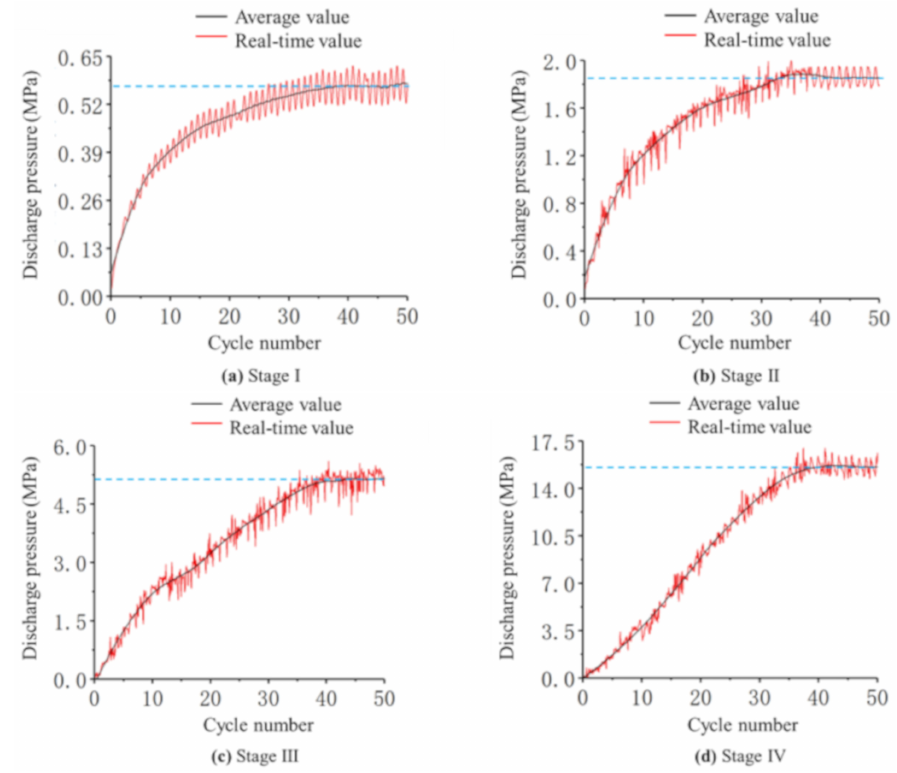
Figure 15. Variation of the discharge pressure with the increase in the cycle number.